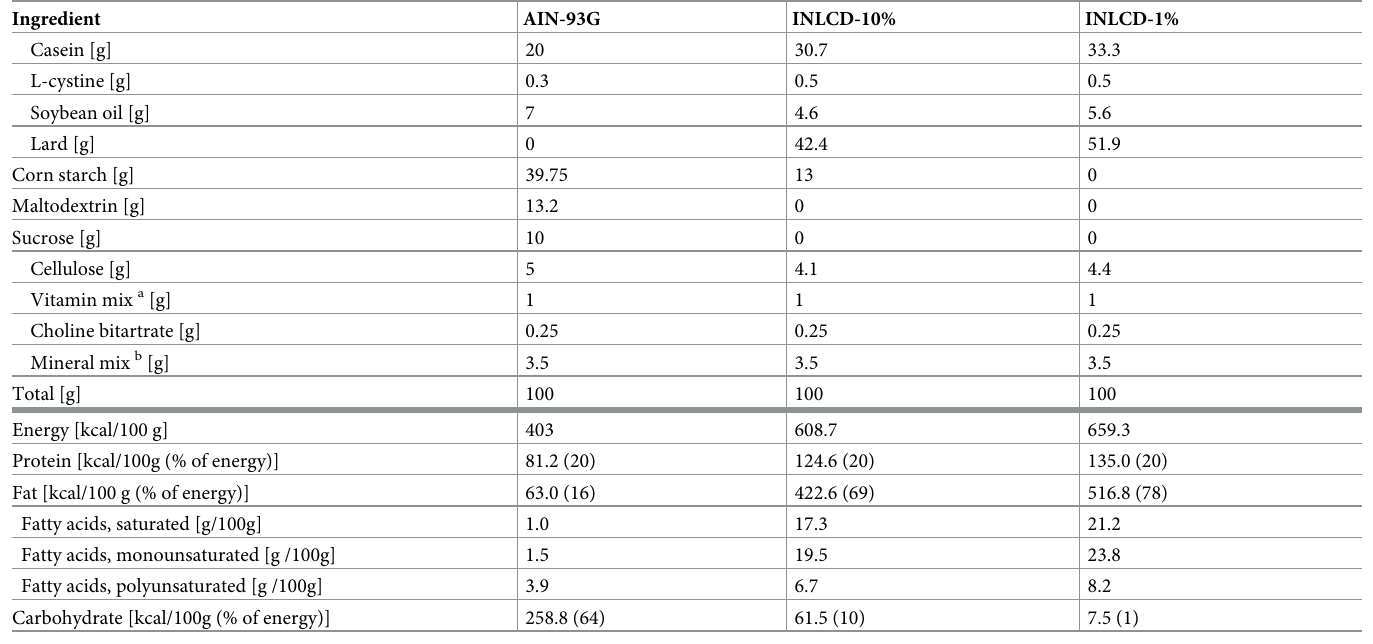
Table 1. Ingredient composition of the diets.